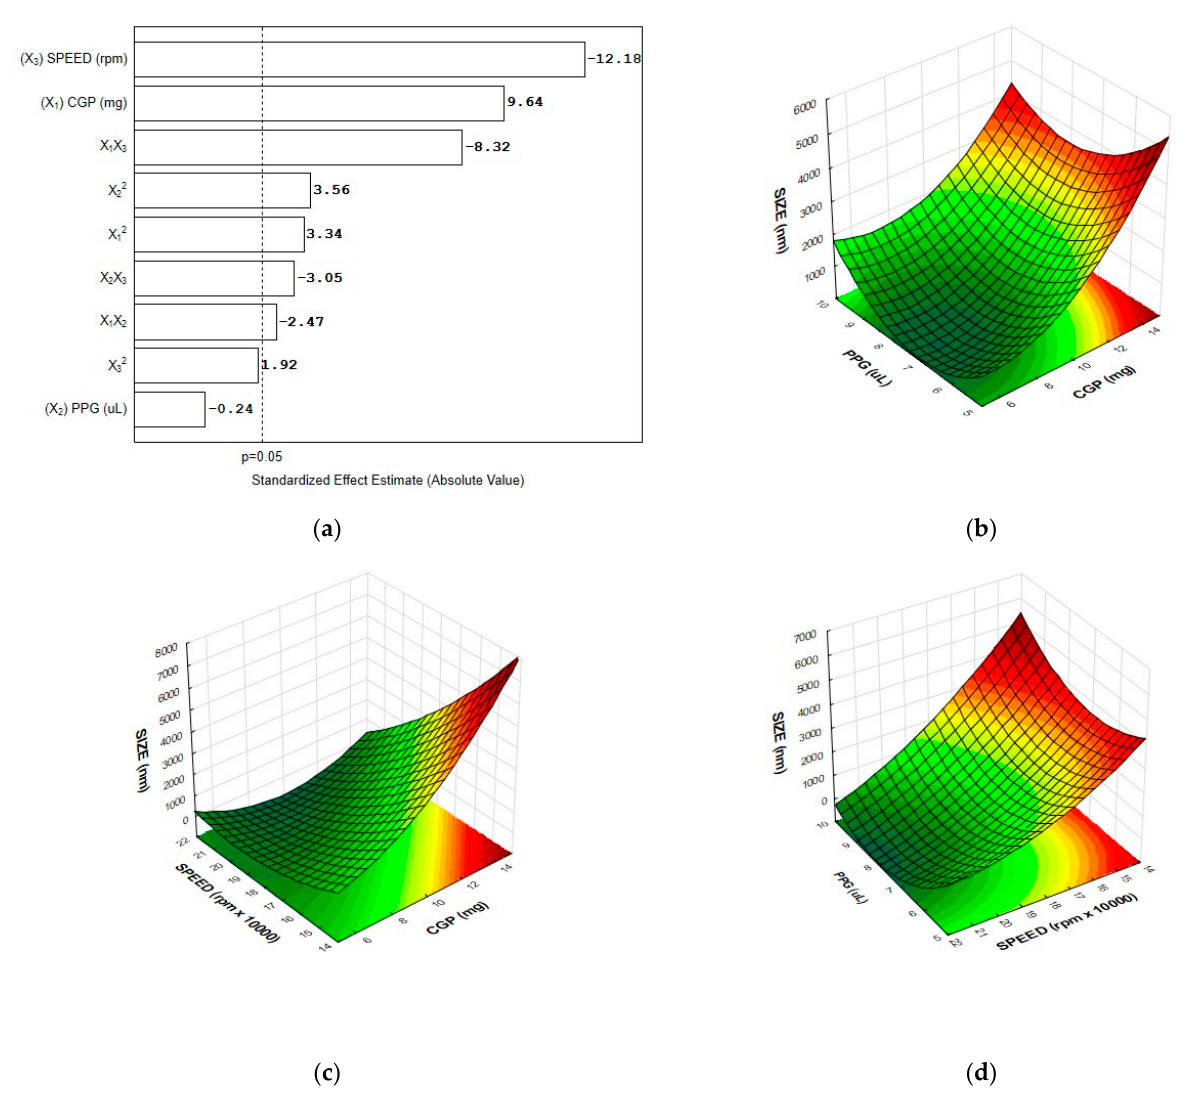
Figure 1. Pareto chart ( a ) and response surface plot for hydrodynamic diameter (size) as a function of ( b ) CGP content and PPG volume; ( c ) CGP content and homogenization speed; and ( d ) PPG volume and homogenization speed ( n = 6 replicates).